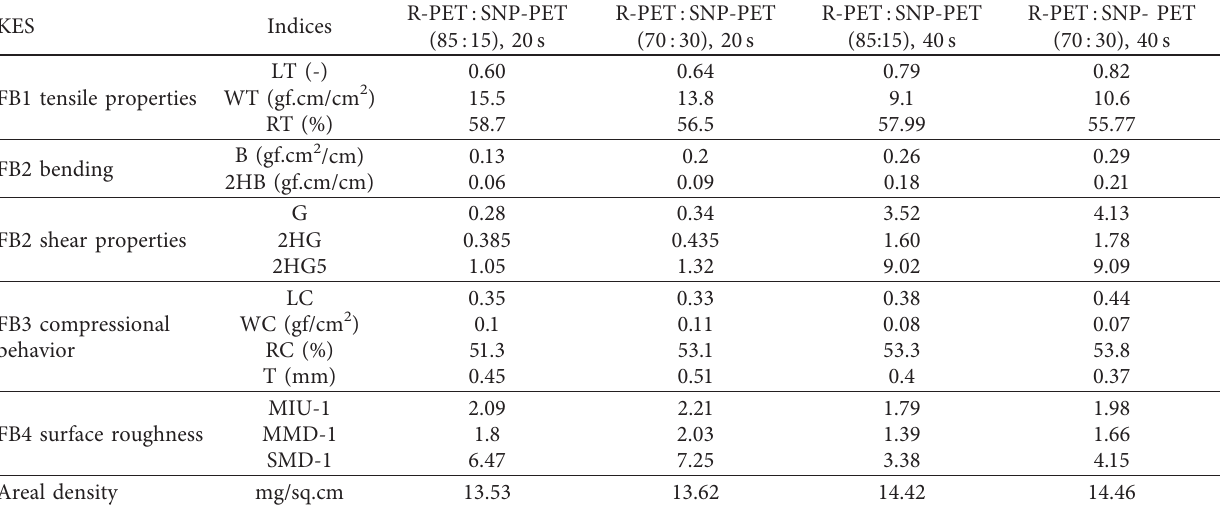
Figure 9: Thick and thin places of the blended yarn sample. Table 7: Statistical results of KES-F indices of four fabric